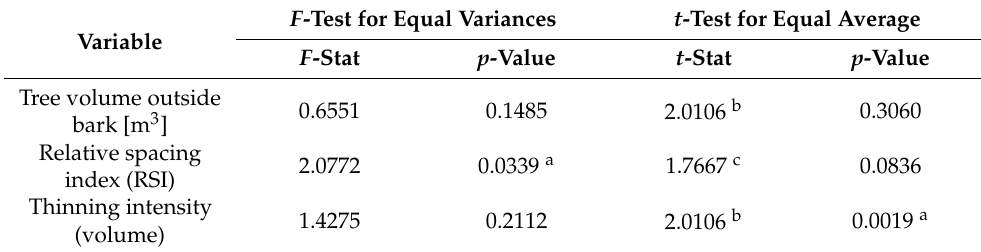
Table 4. Homogeneity of sample plots along the wide (AT35) and narrow (AT27) access trails. F -Test for Equal Variances t -Test for Equal Average Variable F -Stat p -Value Tree volume outside bark [m 3